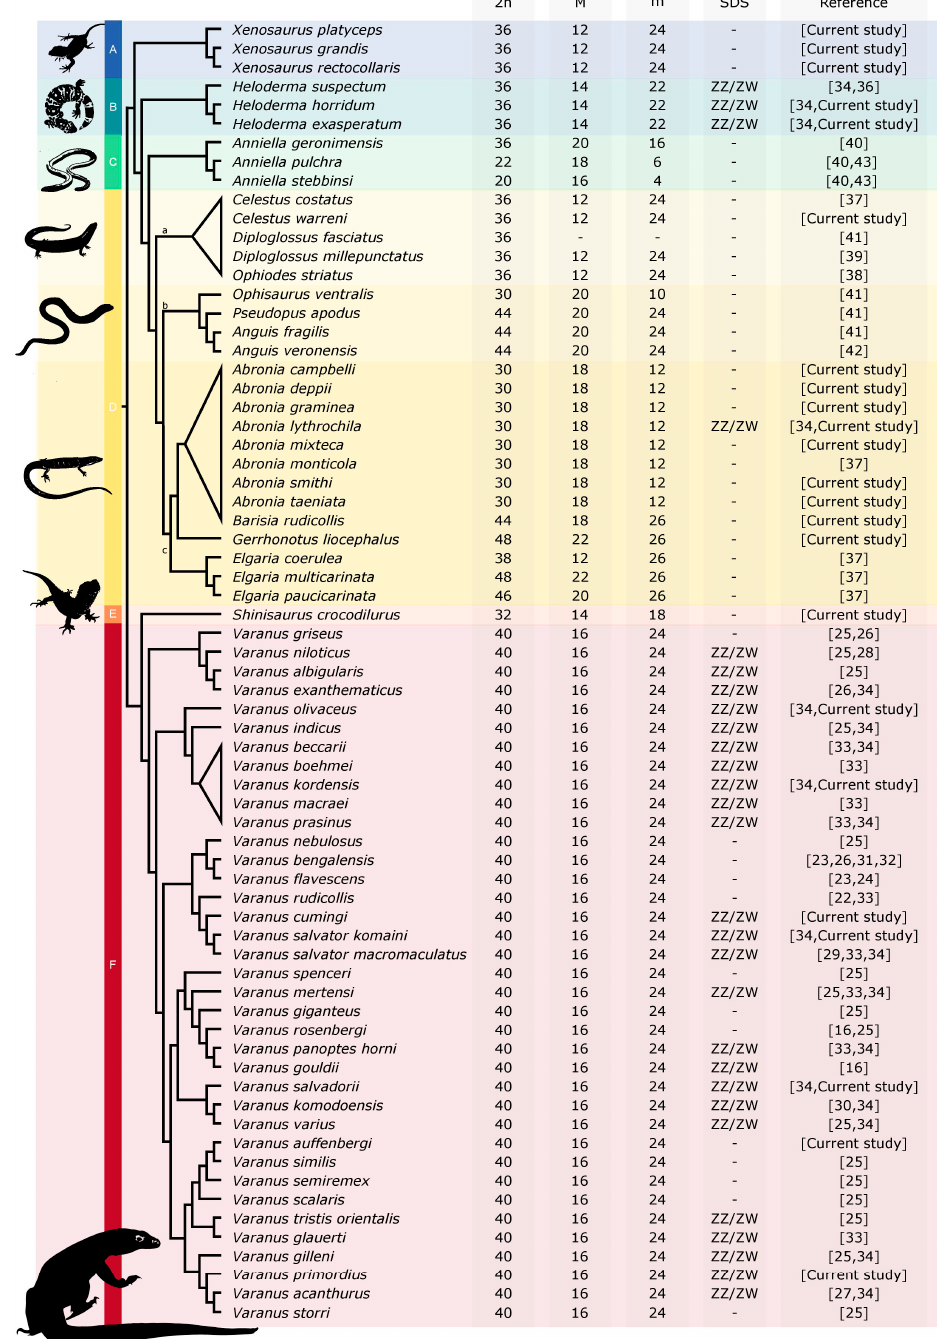
Figure 11. Evolution of karyotypes in anguimorphan reptiles. 2n: diploid chromosome number, M: number of macrochromosomes, m: number of microchromosomes, SDS: sex determination system. A: Xenosauridae, B: Helodermatidae, C: Anniellidae, D: Anguidae, E: Shinisauridae, F: Varanidae, a: Diploglossinae, b: Anguinae, c: Gerrhonotinae. The phylogenetic relationships follow [21,68–71].